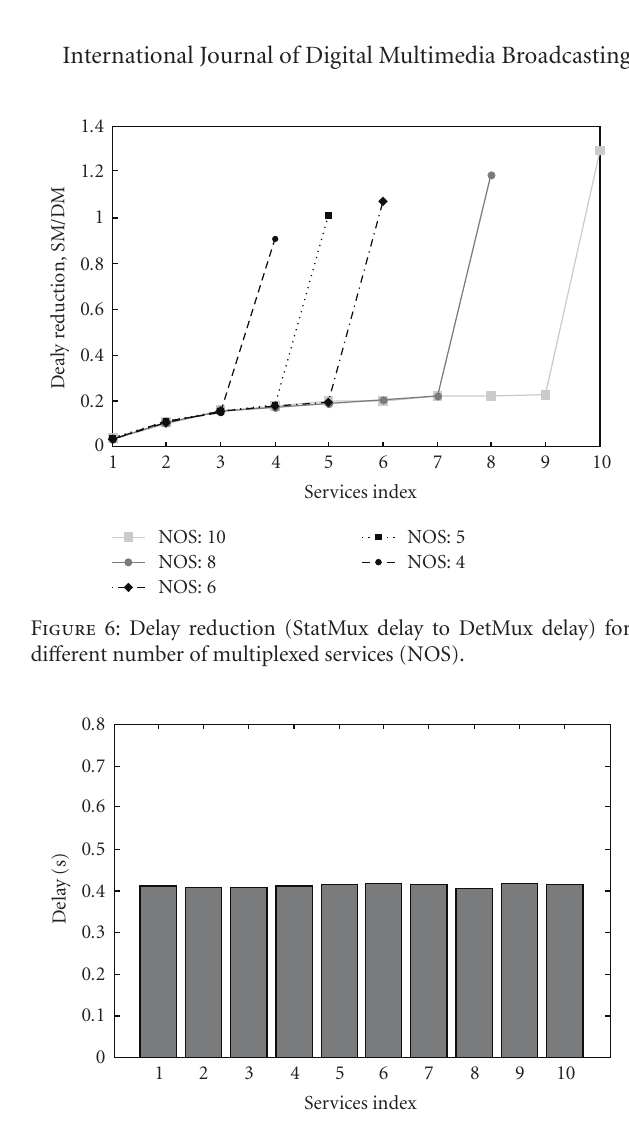
Figure 7: Bu ff ering delay for 10 multiplexed services